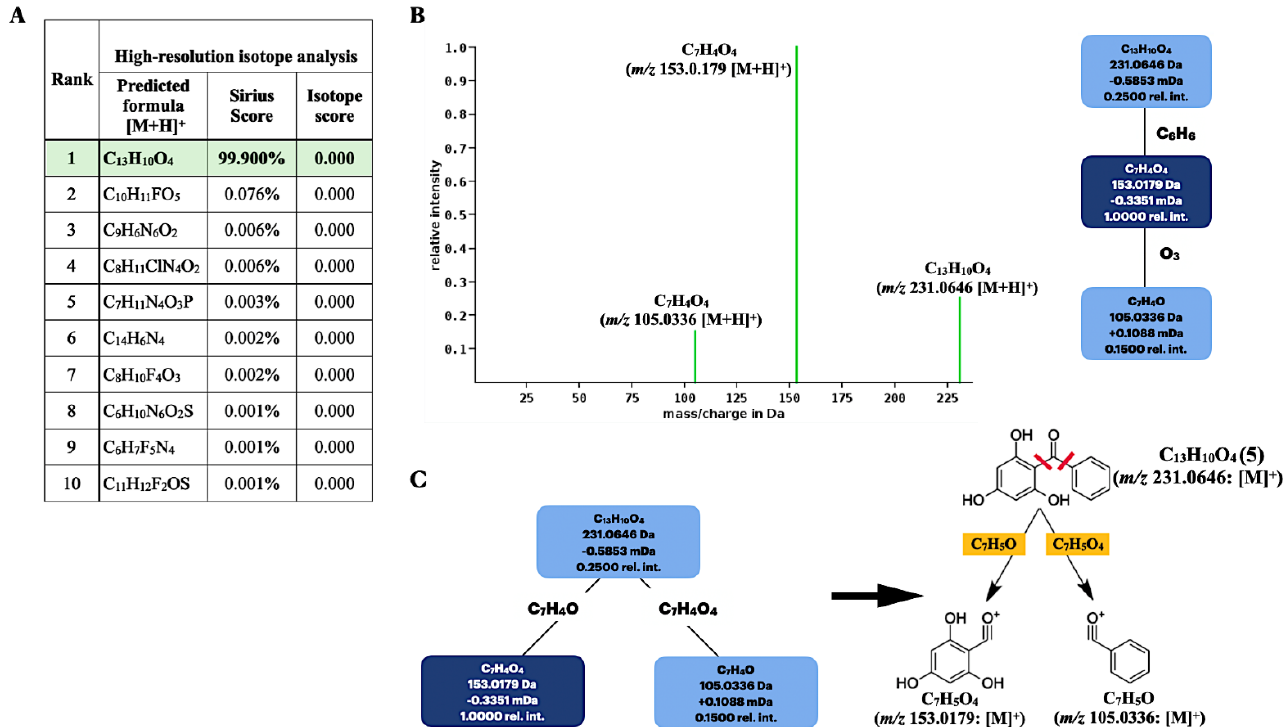
Figure 5. Molecular formula and fragmentation tree annotations of the query metabolite ( m/z 231 . 0646 [M + H] + ) produced by the clones carrying pETDuet - BadA - GmBPS by using the Sirius tool . ( A ) Based on a high - resolution isotope pattern analysis, the molecular formula of the query subject was best explained as C13H10O4 . ( B ) The fragmentation tree simulated by the Sirius tool . ( C ) The proposed fragmentation pathway based on the alpha - cleavage sites of ketones to give two daughter ions with m/z 153 . 018 and 105 . 033 .